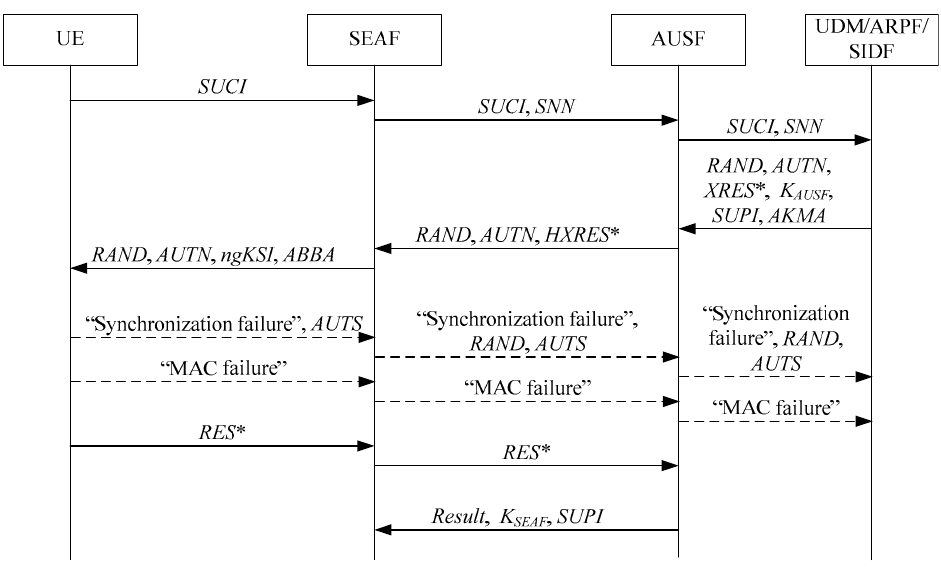
Figure 1. The steps of the latest version of the 5G AKA protocol.